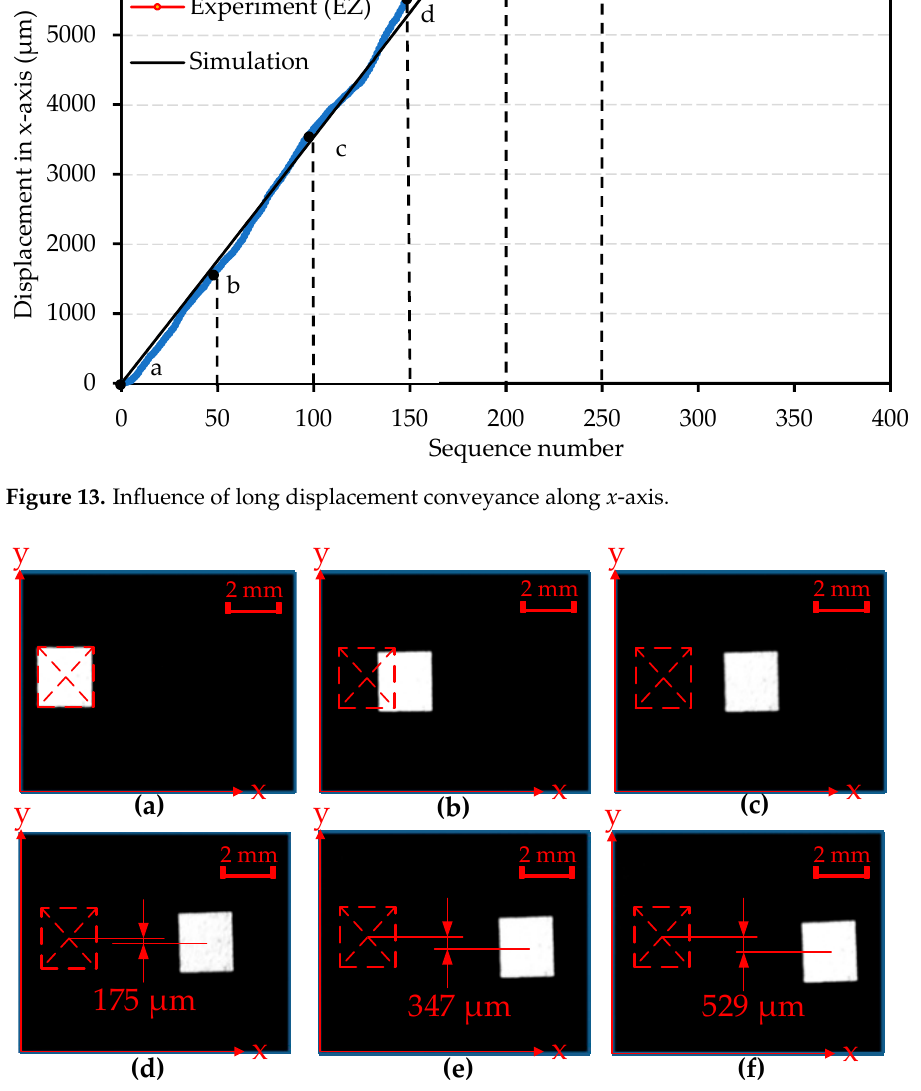
Figure 14. Sticker position in pictures with difference displacement sequences along x -axis. ( a ) The initial position. ( b ) The 50th displacement sequence. ( c ) The 100th dis ‐ placement sequence. ( d ) The 150th displacement sequence. ( e ) The 200th displacement sequence. ( f ) The 250th displacement se ‐ quence.